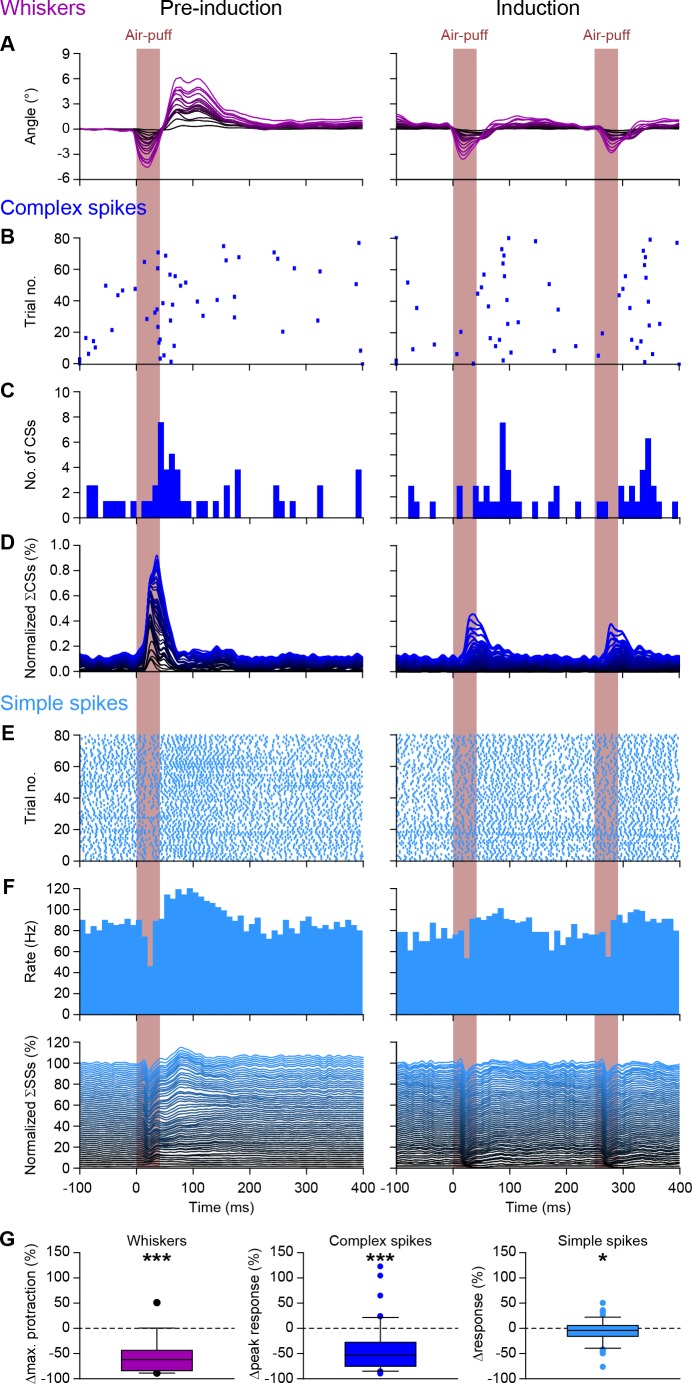
Purkinje cell responses during 4 Hz air-puff stimulation.(A) Normalized stacked line plots showing the whisker movement in 16 mice during the pre-induction block (100 trials; left) and during the induction block (80 trials; right). The retraction caused by the air flow is largely intact, but the subsequent touch-induced whisker protraction is largely reduced during 4 Hz stimulation as compared to 0.5 Hz stimulation during the pre-induction block. (B) Raster plots of the complex spike responses to whisker pad air-puff stimulation during the first 80 trials of a pre-induction block and during the 80 trials of the induction block with the accompanying peri-stimulus time histograms (C). (D) Normalized stacked line plots show that the rate of complex spike responses is reduced upon a higher stimulation frequency (n = 55). (E–F) The same plots depicted for the simple spike response. (G) Box plots showing the decreased whisker, complex spike peak response and simple spike modulation during the first 200 ms after puff onset. *p<0.05; ***p<0.001 (Wilcoxon matched-pairs test). See also Source Data File.10.7554/eLife.38852.020Figure 5—figure supplement 2—source data 1.Data for Figure 5—figure supplement 2.